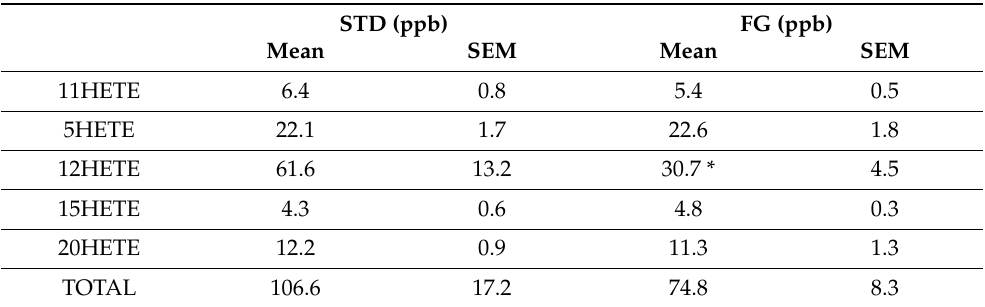
Table 3. Lipid mediators derived from arachidonic acid from rats ( n = 8–9) supplemented or not with D ‐ fagomine for 6 months.